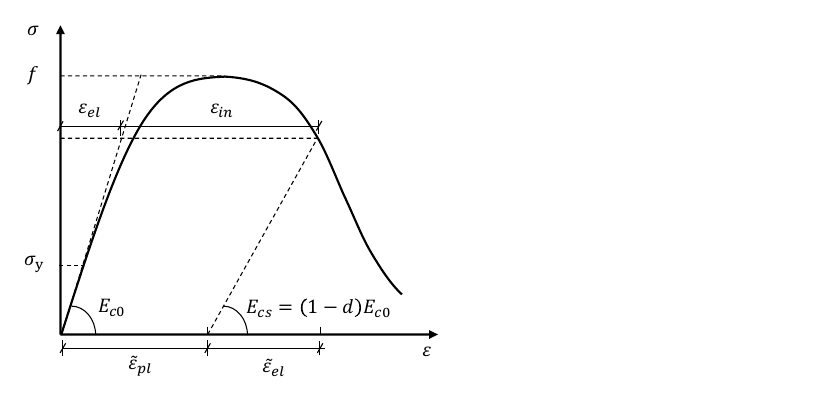
Figure 6. Tensile behavior defined for the steel reinforcement.